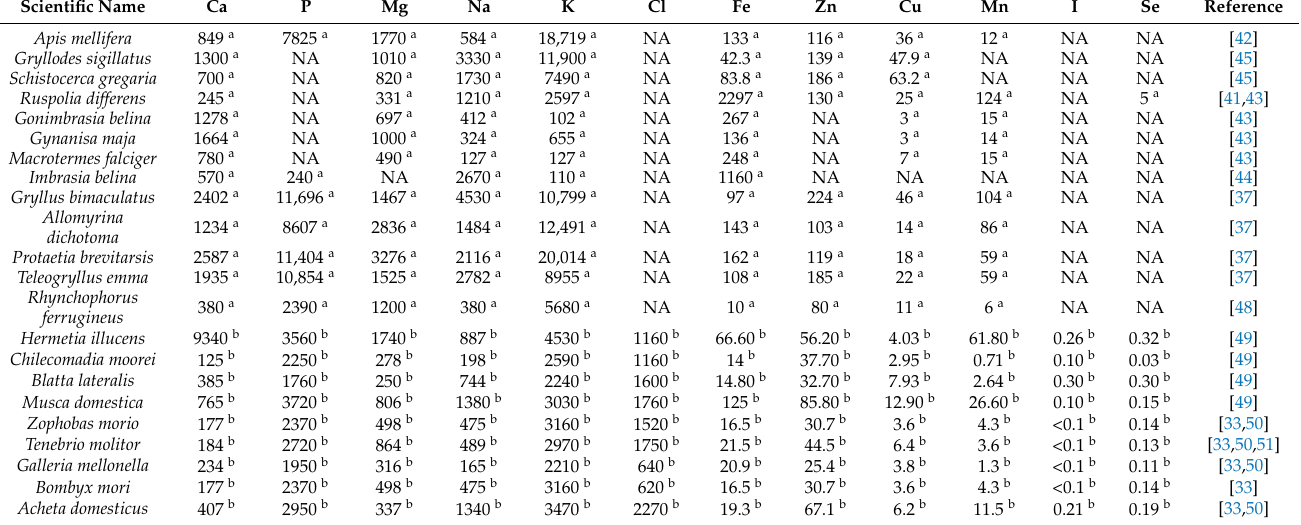
Table 5. Mineral composition and content of selected